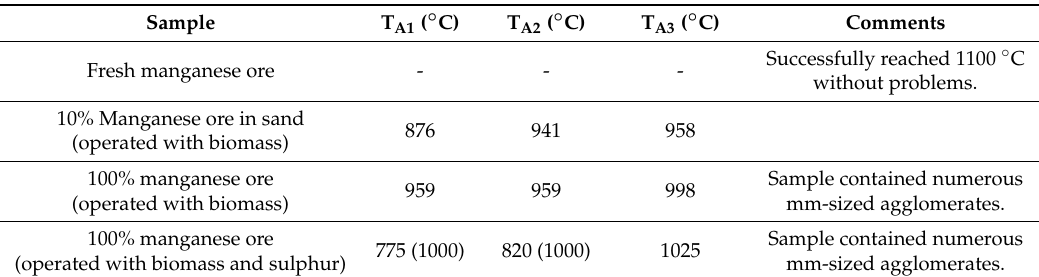
Table 4. Results of agglomeration